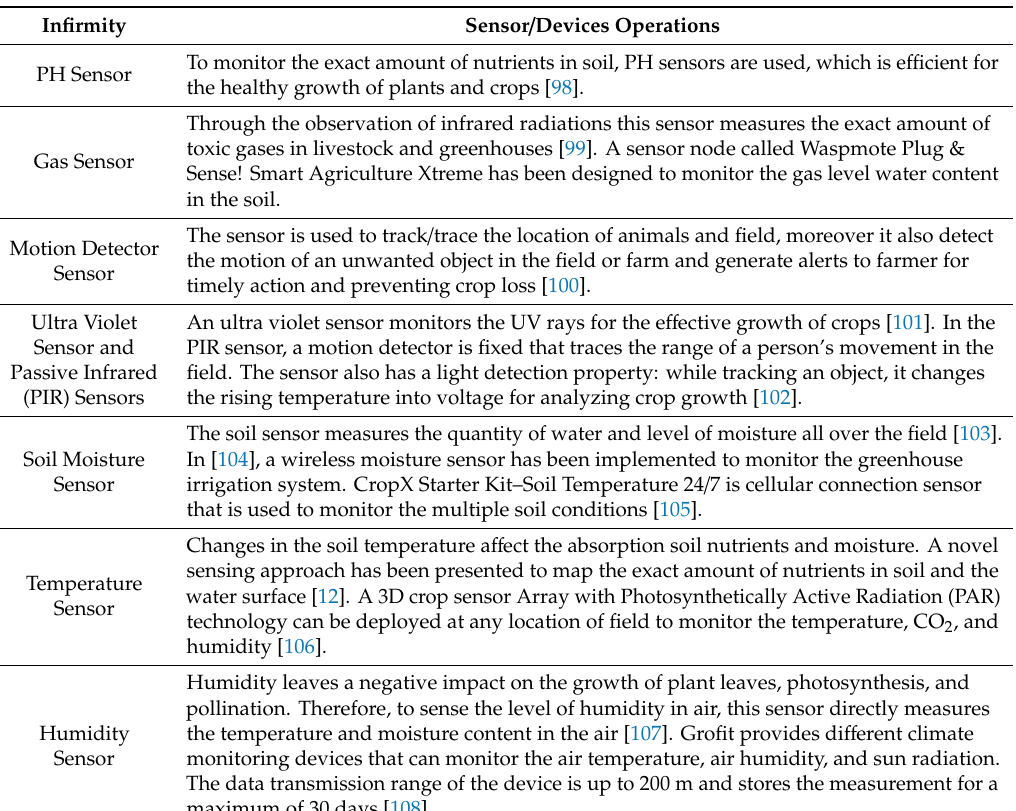
Table 7. Sensor / devices